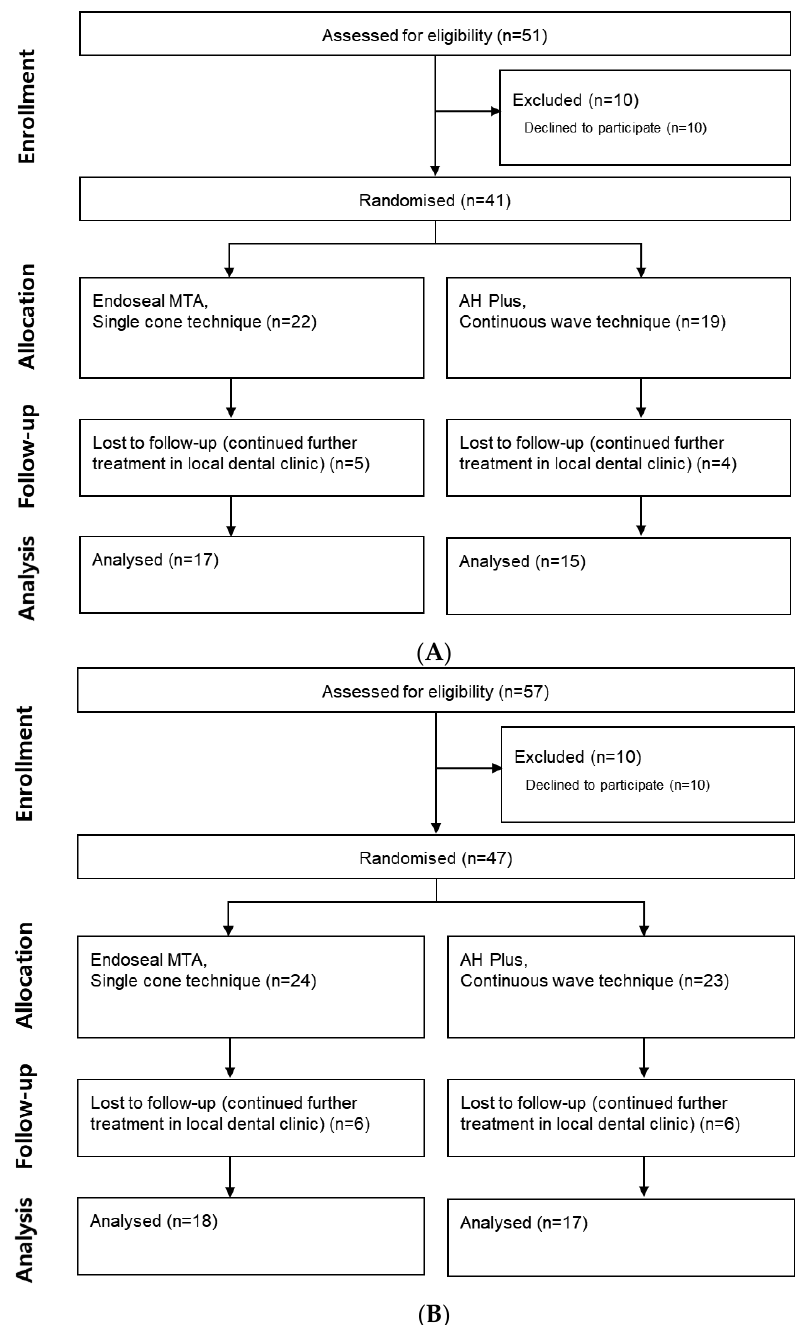
Figure 1. ( A ) Flow chart of patient selection in group 1. ( B ) Flowchart of patient selection in group 2.